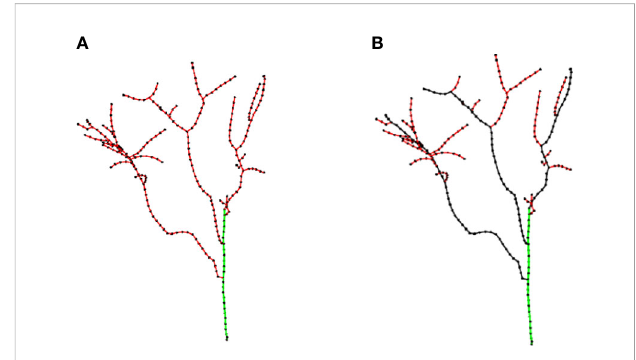
FIGURE 6 Results of skeleton analysis. (A) Trunk (green edges). (B) Primary branches (black edges).